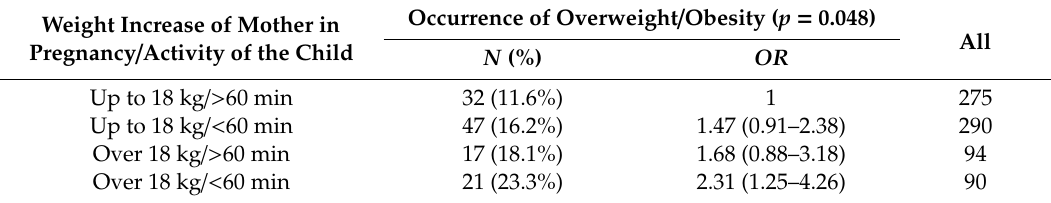
Table 6. Odds ratio of overweight and obesity depending on the mother’s weight gain during pregnancy and the child’s level of physical